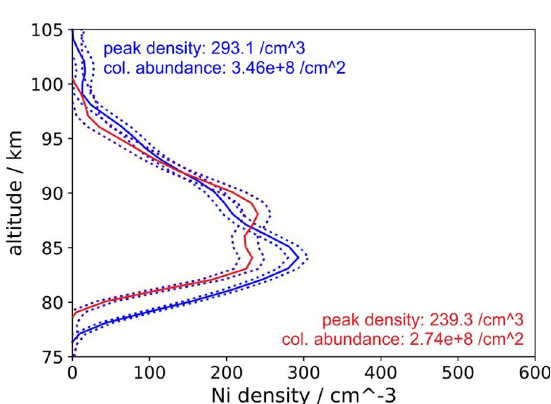
Fig. 3: Ni density profiles for 18:30-19:30 UTC (blue) and 21:00 – 22:00 UTC (red) on Jan. 8, 2018. Bin width is 1 km. The plot is smoothed by a 7-point Hann-filter for visualization only .